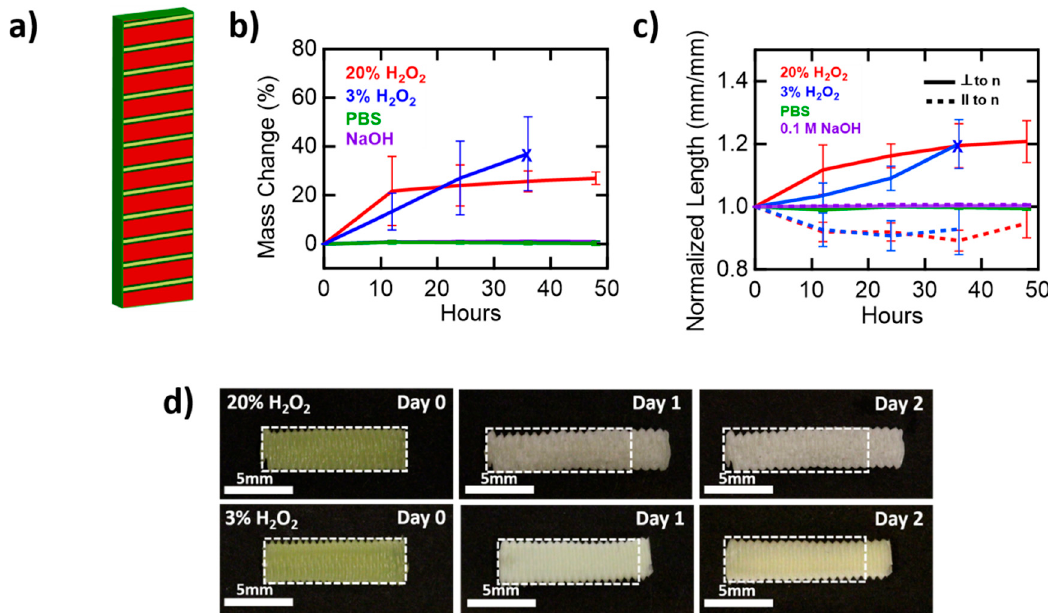
Figure 2. Shape change and mass change of 3D printed uniaxial strips. ( a ) Print schematic of single layer uniaxial strips. Print path is set to be along the short axis of the rectangular strips resulting in nematic director parallel to the short axis and perpendicular to the long axis. ( b ) Mass change (%) as a function of time for uniaxial strips in all four media. Test specimens in oxidative media swell significantly while those in PBS and NaOH solution showed approximately no change. ( c ) Normalized length (mm / mm) for uniaxial strips, parallel and perpendicular to the nematic director (n), as a function for time for strips in all four media. Films in oxidative media demonstrate anisotropic swelling with contraction along the short axis and elongation along the long axis. ( d ) Shape change of uniaxial strips before and after oxidation in 20% H 2 O 2 and 3% H 2 O 2 .